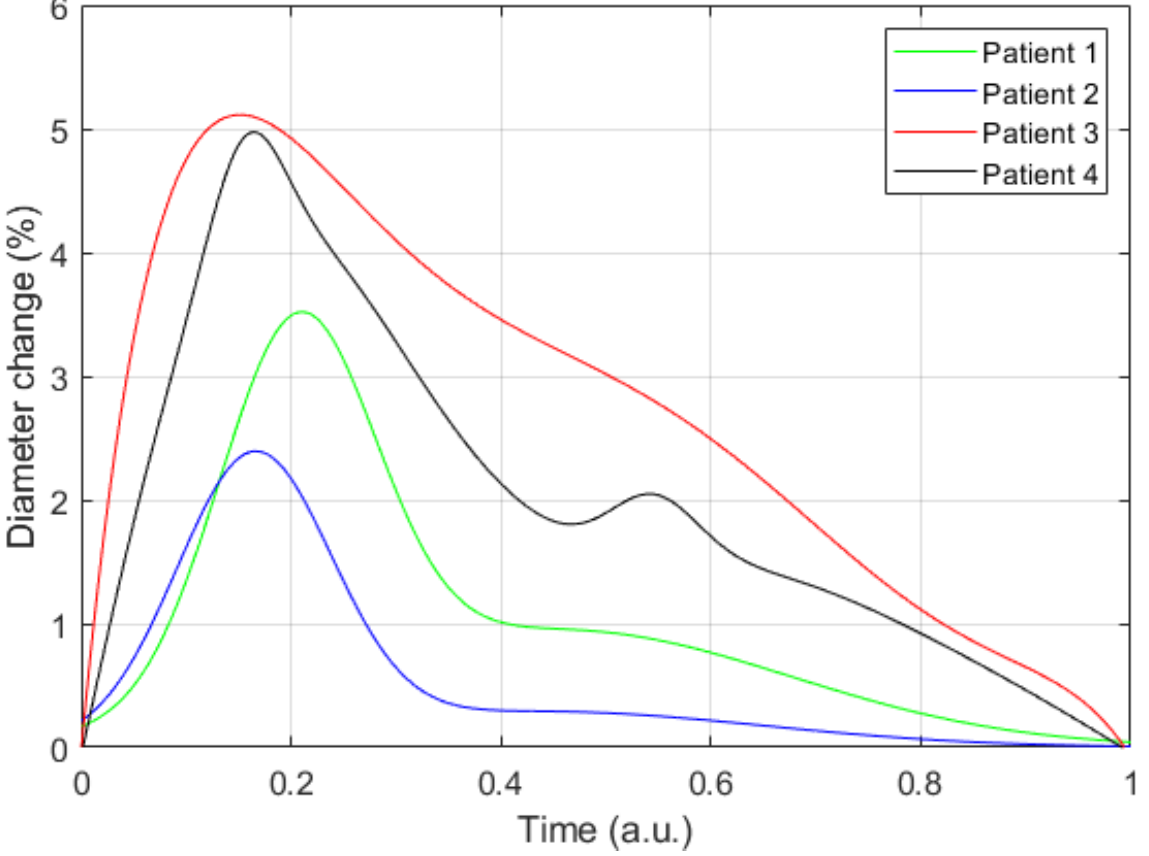
Figure 10. The resulting curves of diameter changing for four patients. Basically, the local brachial elasticity was estimated from the time delay between the two recorded signals. The maximum of the first derivative was selected as a specific point to get the PTT between two points with an inaccuracy of ± 0.001 s corresponding to a sample frequency of 500 Hz. According to Equation (5) and based on the obtained PTT values, the local brachial artery elastic modulus was determined and illustrated in Table 3: the obtained values correspond to healthy arteries [59]. However, these values can vary significantly with blood pressure change and the bio sensor should be recalibrated according to the possible